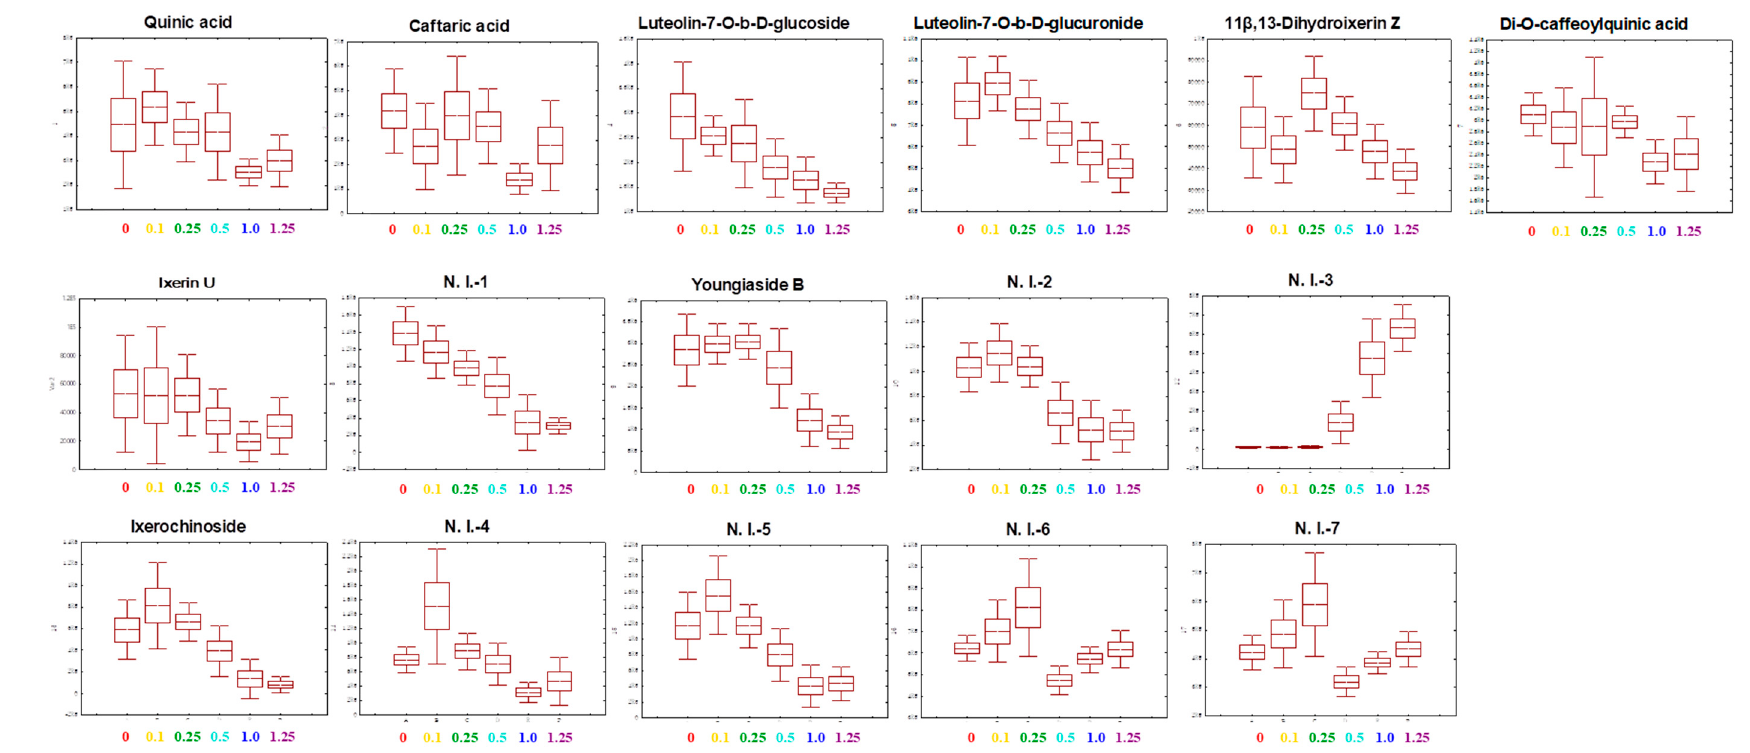
Figure 7. Box-and-whisker plots of metabolites in C. denticulatum subjected to different energy levels of UV-B radiation at 4 days after treatment using ultra high performance liquid chromatography-linear ion trap-Orbitrap mass spectrometer (UPLC-LTQ-Orbitrap-MS).